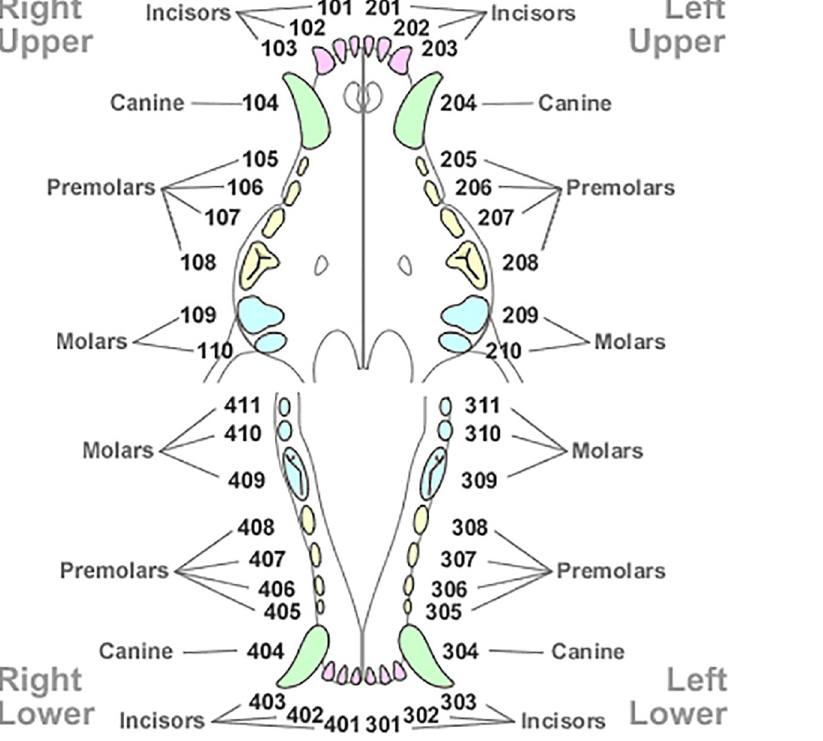
Fig 1. The TRIDAN modified system for dog teeth classification. Adapted from Crossley